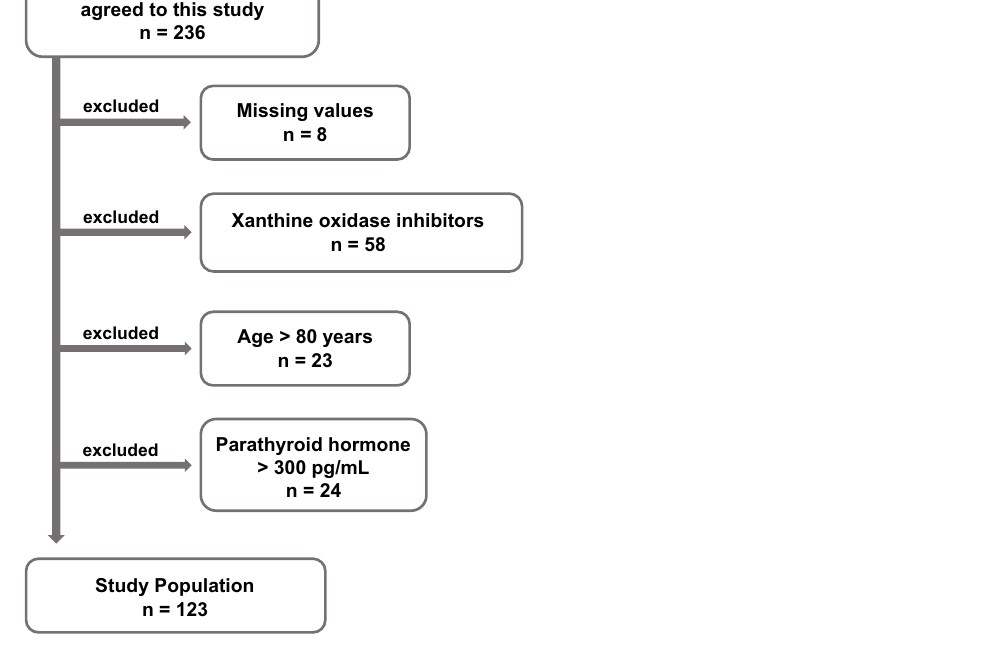
Figure 1. Participant screening